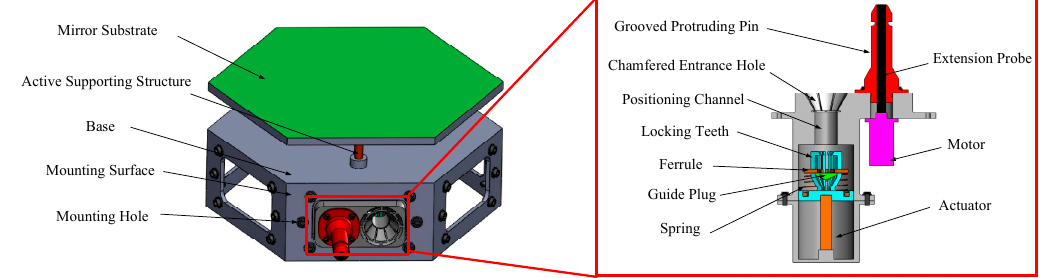
Figure 4. Introduction of a modular PMA (left) and the design scheme of SMALL (right).